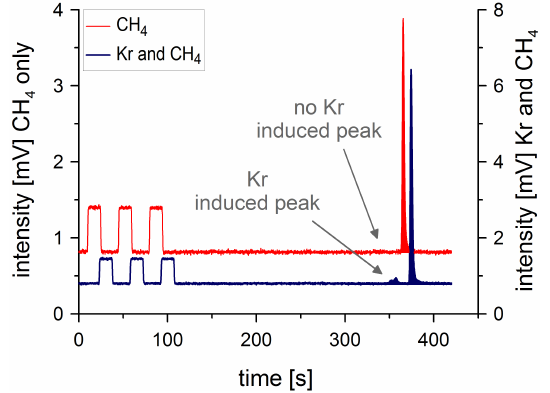
Fig. 4. A small krypton signal is visible when comparing the m/z 43 traces of δ 13 C-CH 4 measurements in an atmospheric air mixture (dark-blue line, right axis) and in a pure CH 4 gas (red line, left axis), where the latter contains no Kr. Both peaks of CH 4 occur on m/z 43, while the baseline separated peak induced by remnant Kr occurs only in the atmospheric sample. To avoid an overlap of the displayed peaks, the chromatogram of the pure CH 4 is shifted by 15s.